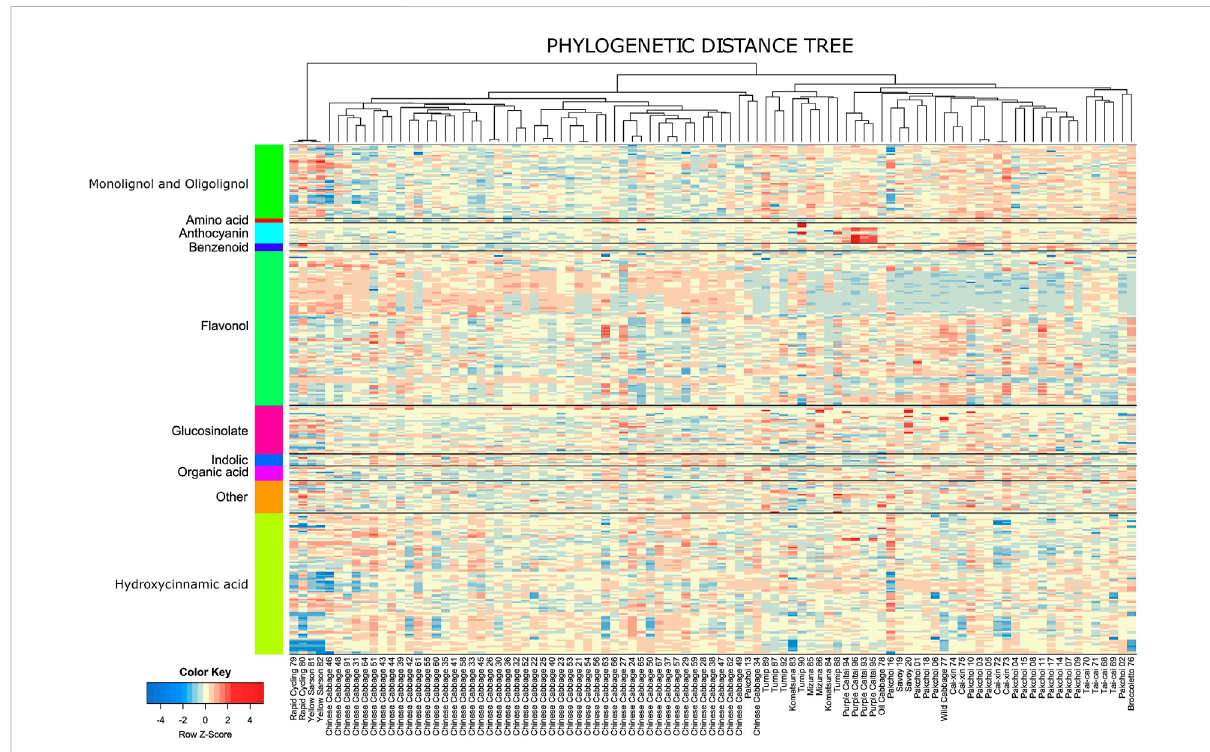
FIGURE 3 Heatmap of the relative metabolite abundance across the accessions. The heatmap is scaled row-wise (Z-scores from the log values of the metabolite intensity); thus, the colors represent the deviation from the average value obtained for a metabolite. The columns are ordered according to the midpoint-rooted phylogenetic